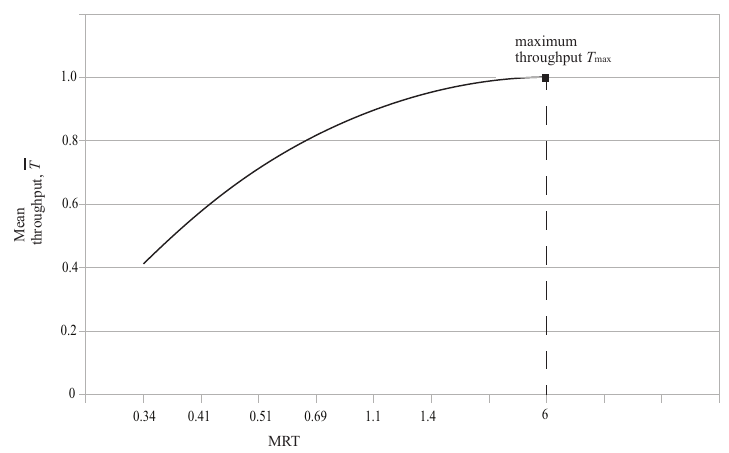
Figure 3. Relationship between MRT and mean